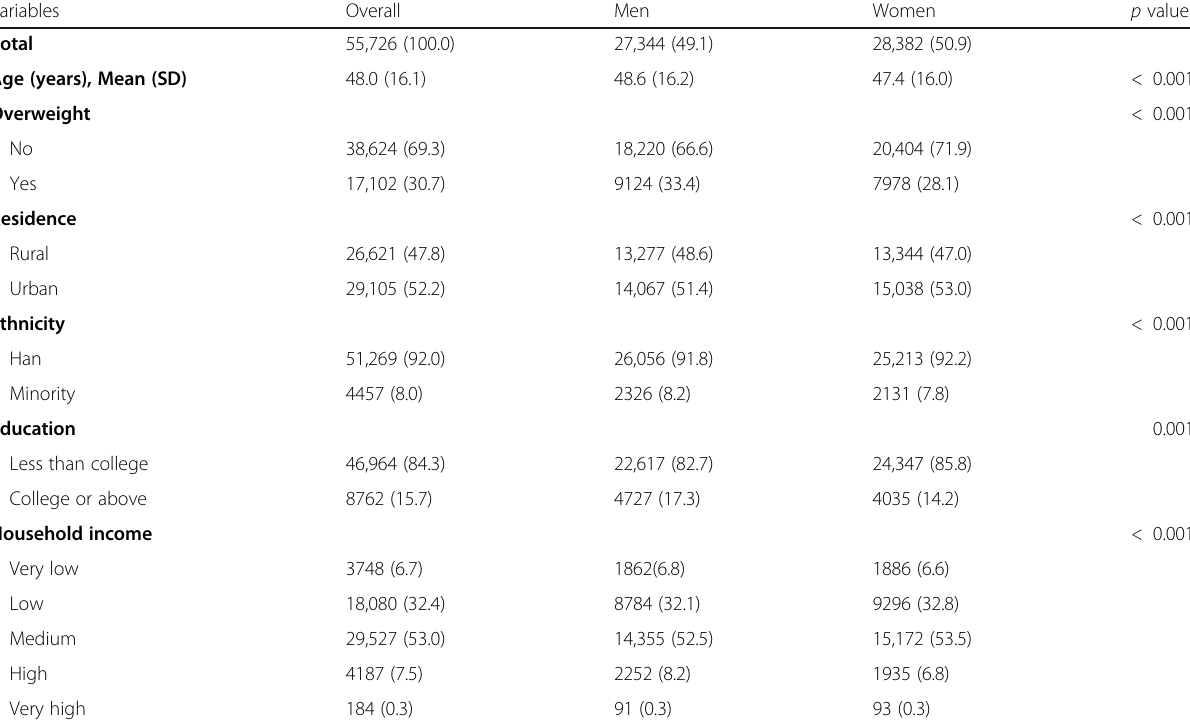
Table 2. Pronounced gender differences in overweight were found, with more fluctuations among men. Table 1 Descriptive statistics of variables used, n